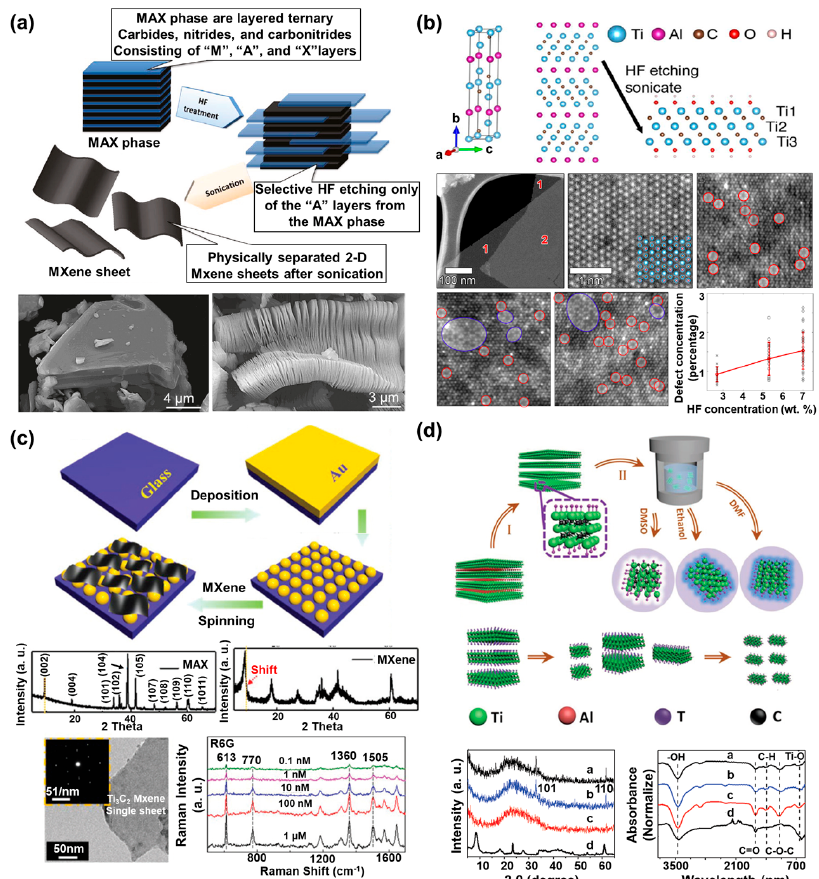
Figure 2. Definition and characteristics of MXenes. ( a ) Schematic diagram of the synthesis process from the MAX phase to the MXene nanosheets, and SEM images of the MAX phase (Ti 3 AlC 2 ) before and after hydrofluoric acid (HF) treatment (reprinted with permission from [37]; copyright (2012) American Chemical Society). ( b ) Crystal structure images of the MAX phase of Ti 3 AlC 2 , and the low-magnification and atomic resolution high-angle annular dark field (HAADF)-scanning transmission electron microscopy (STEM) images of Ti 3 C 2 T x (reprinted with permission from [39]; copyright (2016) American Chemical Society). ( c ) Schematic image of the MXene / Au nanostructure (NS) SERS substrate fabrication process, XRD pattern, and TEM image of synthesized MXene (Ti 3 C 2 T x ), and the Raman spectra of R6G on the MXene / Au NSs SERS substrate with di ff erent concentration ranges of R6G (reprinted with permission from [45]; copyright (2019) The Royal Society of Chemistry). ( d ) Schematic image of the MXene-derived quantum dot (MQD) synthesis process using di ff erent solvents such as the dimethylformamide (DMF), DMSO, and ethanol (f-MQDs, s-MQDs, and e-MQDs, respectively), and the XRD pattern and FTIR spectra of the e-MQDs (black), f-MQDs (blue), and s-MQDs (red) (reprinted with permission from [41]; copyright (2018) John Wiley and Sons,